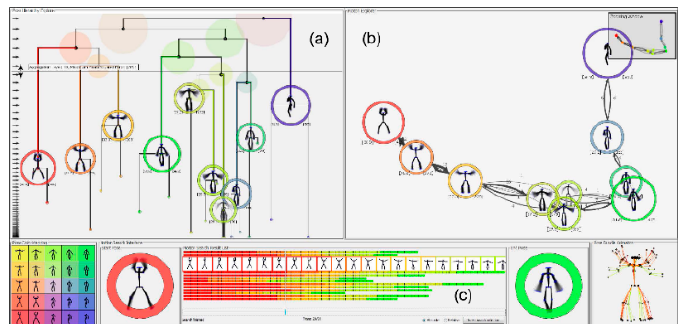
Figure 31. Snapshot of MotionExplorer interface with: ( a ) a treemap for browsing the hierarchical structure; ( b ) a node-link diagram viewing motion aggregations and transformations; and ( c ) a search view for query and result analysis [83].